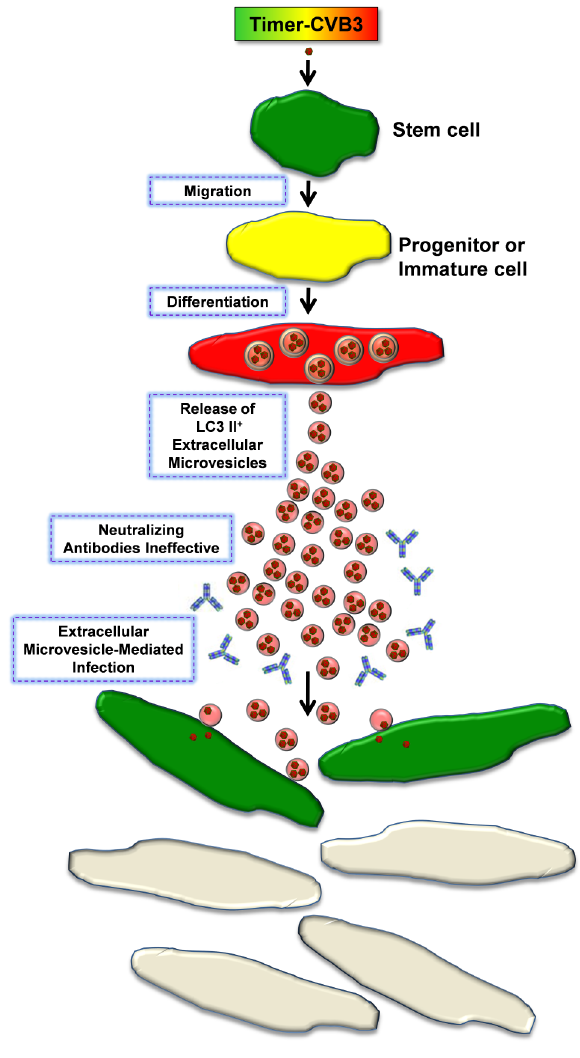
Figure 14. Model of Timer-CVB3 dissemination by EMVs triggered following stem cell migration and differentiation. NPSCs are highly susceptible to CVB3 infection. Upon progenitor cell migration and differentiation, LC3 II + EMVs containing infectious virus are shed by cells. Both the differentiation process and viral infection enhance shedding of single membrane EMVs derived from the autophagy pathway. Neutralizing antibodies may be ineffective against infectious virus within the protected environment of the extracellular microvesicle. Fusion of EMVs with cells assists in CVB3 dissemination and expansion to new target cells, some of which do not express the CVB3 receptor for entry (CAR). New target cells are identified by the expression of recent viral protein (green).